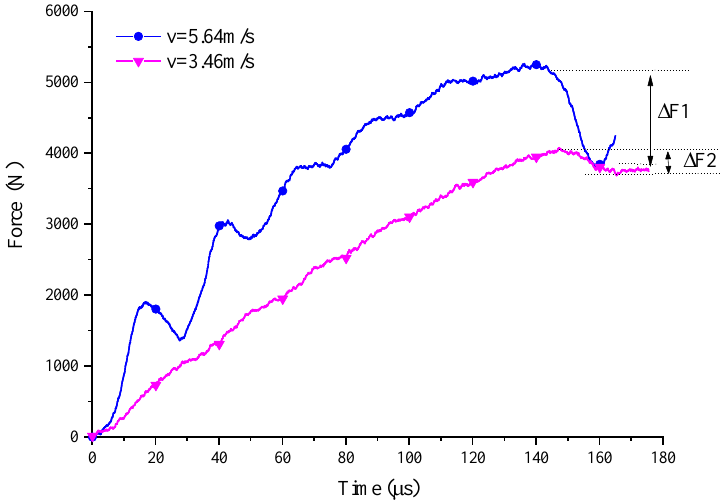
Figure 13. Load–time curve of 45 ◦ SCS at v = 4.62 m/s and v = 3.78 m/s.